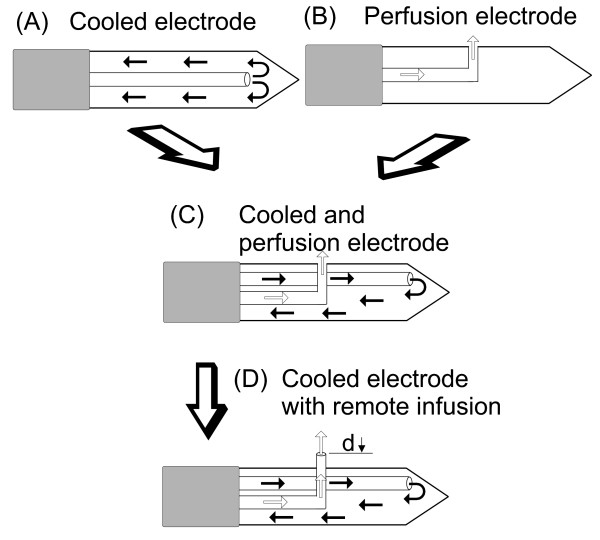
Designs of RFA electrodes with internal cooling and/or saline perfusion into the tissue. (A) Internally cooled electrode: water is circulated during ablation to cool tissue next to the applicator and prevent tissue charring. (B) Perfusion electrode: This allows the infusion of saline into tissue through one or more outlets on the electrode surface. (C) Hybrid applicator combining internal cooling and saline perfusion through outlets on the electrode surface. (D) Hybrid applicator combining internal cooling and saline perfusion through an outlet placed at a distance (d) from the electrode surface.